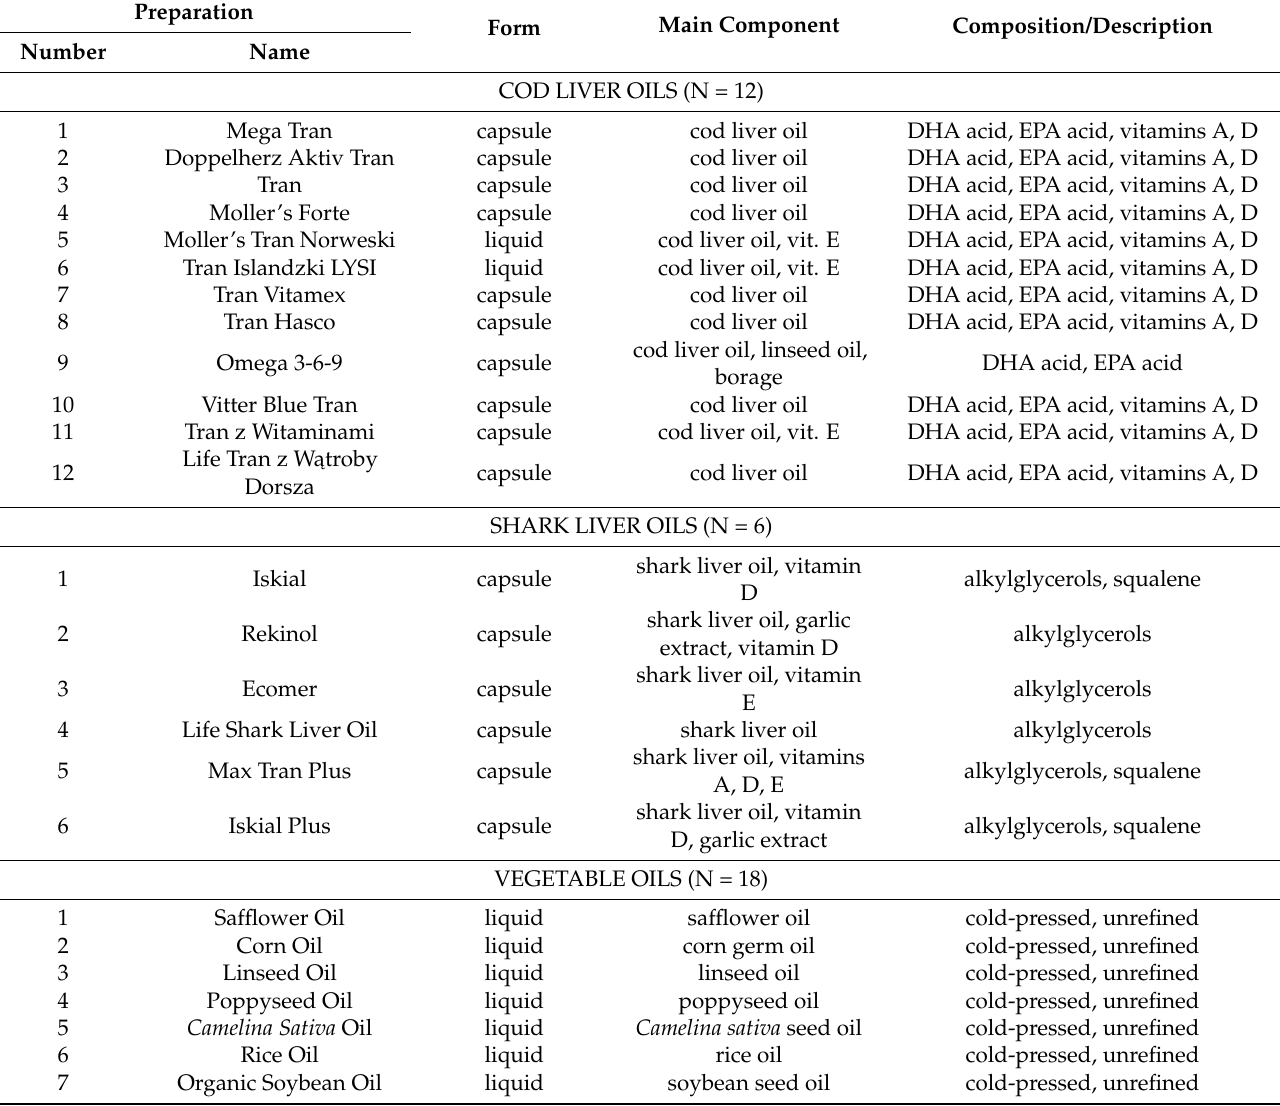
Table 1. Characteristics of the tested dietary